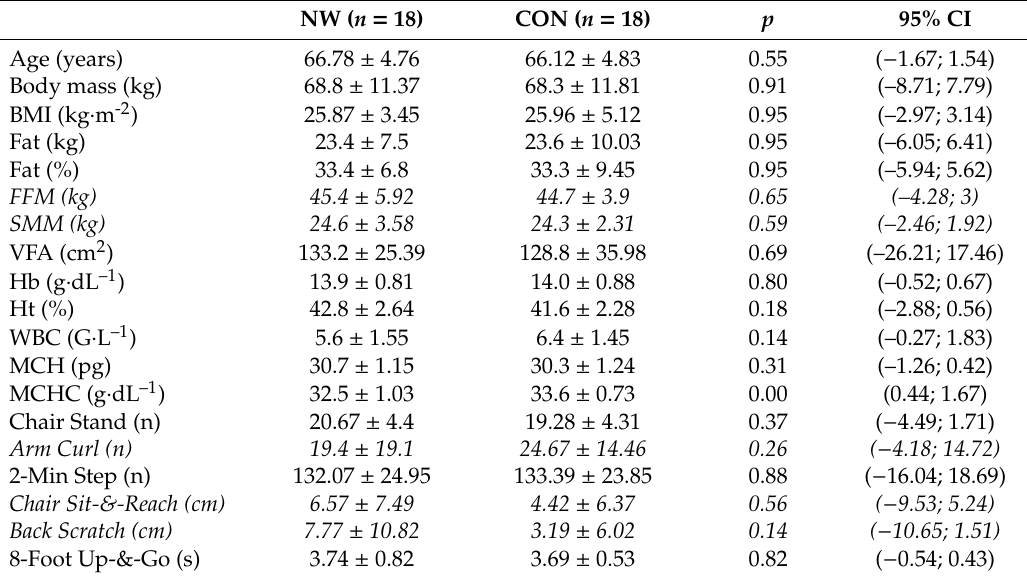
Table 1. Anthropometric, morphological, and physical fitness characteristics of participants.